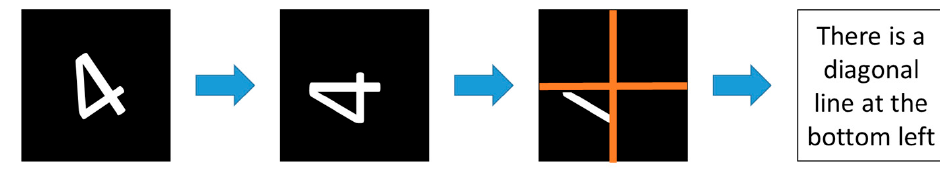
Figure 11. Tilt correction example of “4”.